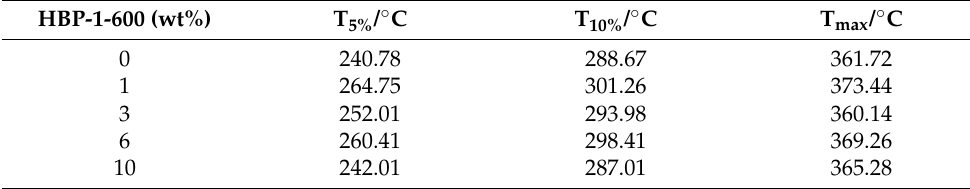
Table 2. T 5% , T 10% and T max of UPR in different ratios of HBP-1-600.